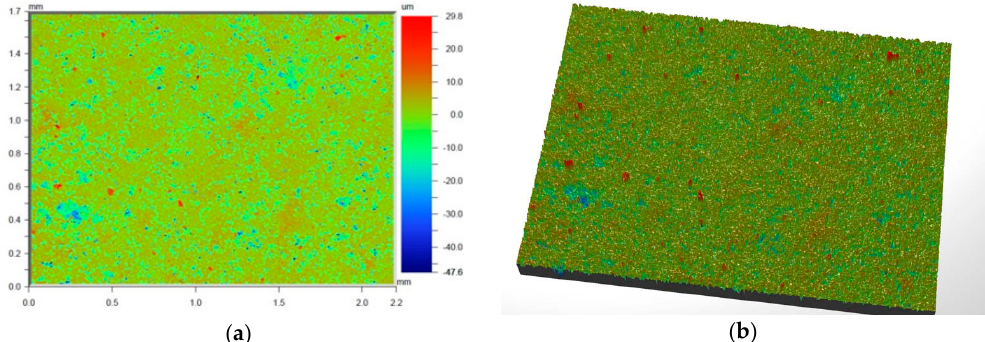
Figure 14. 2D ( a ) and 3D ( b ) profilographs of PW3 sample at a magnification of ×2.9.